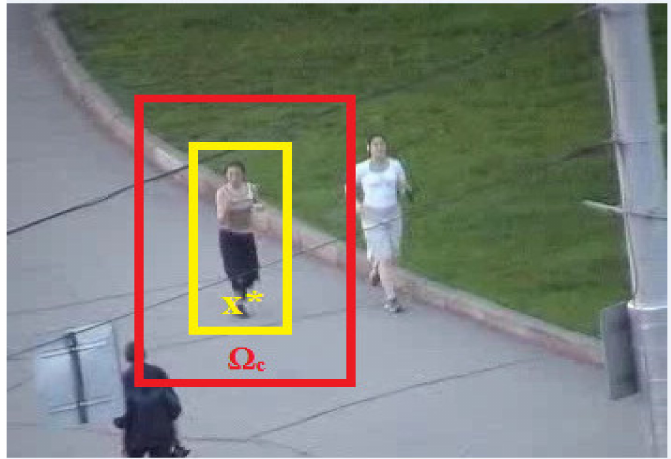
Figure 1. Graphical representation of spatial relationship between object and its context. Confidence map of target location is described in